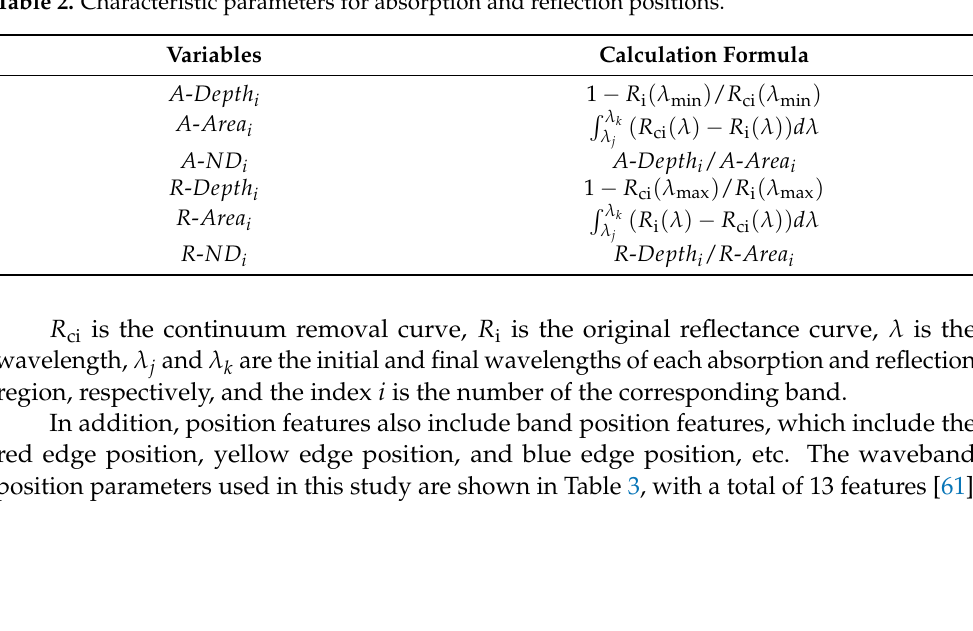
Figure 2. Characteristic absorption and reflection positions of the winter wheat for the three nitrogen treatments. (A) Absorption position, and (R) reflection position. Table 2. Characteristic parameters for absorption and reflection